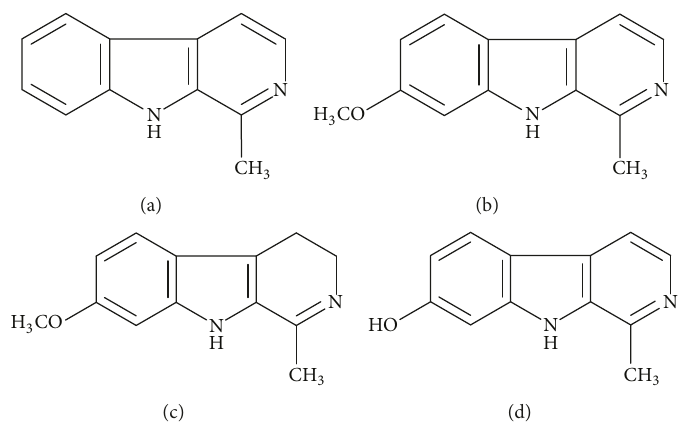
Figure 5: The main 𝛽 -carboline alkaloids of Peganum harmala L.